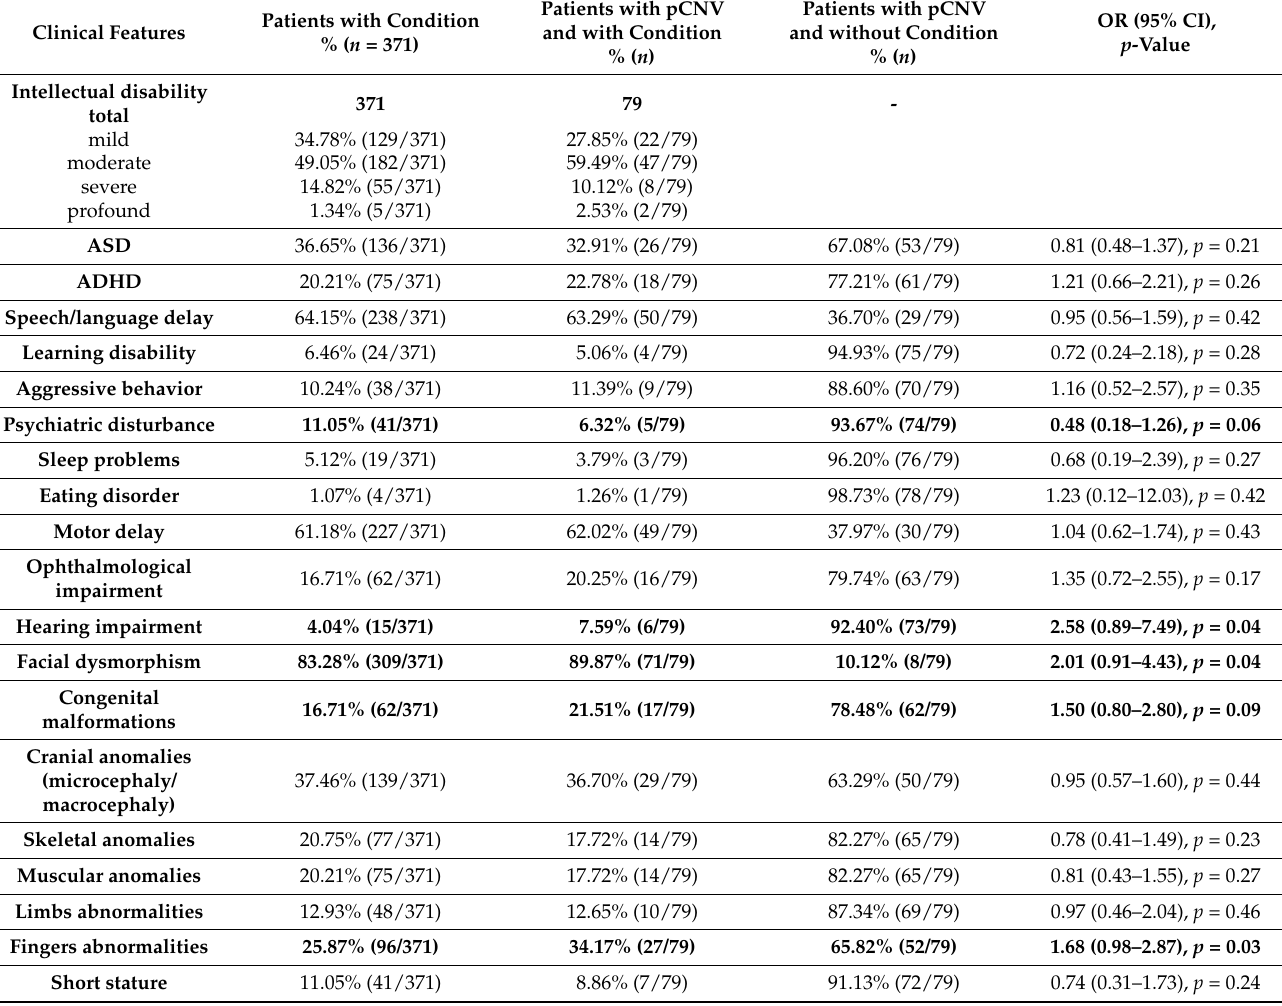
Table 2. Clinical characteristics of patients with unexplained GDD/ID in our cohort and the diagnosis yield of pCNVs in cases with and without a condition. Odds ratio—OR (95% confidence intervals— CI), p -value presented for each